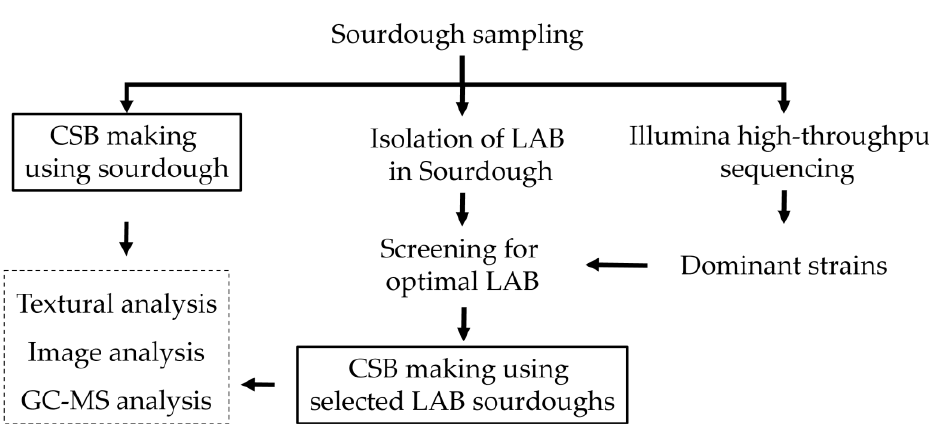
Figure 1. Flowchart for the present study.